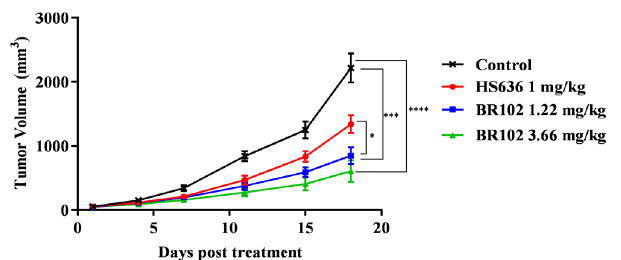
Figure 5. BR102 inhibited tumor growth in a murine tumor model. C57BL/6JNifdc mice were sub- cutaneously injected with MC38/hPD-L1 cells. When tumor volumes reached 50 mm 3 , mice were treated with PBS, HS636, or BR102 ( n = 8 for each group). The tumor volume was measured twice per week.